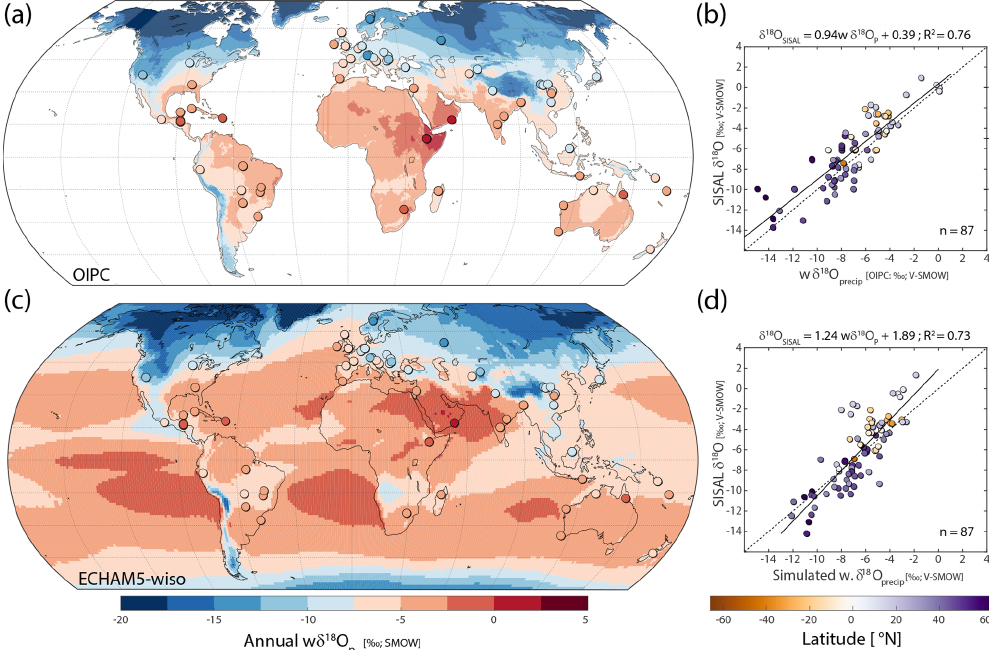
Figure 3. Comparison of SISAL data with observational and simulated wδ 18 O p for the modern period. (a) Comparison between SISAL δ 18 O averages (‰; V-SMOW) for the period 1960–2017 CE with OIPC data (‰; V-SMOW). (b) Scatterplot of SISAL modern δ 18 O averages as in (a) versus wδ 18 O p extracted from OIPC (i.e. background map in a ) at the location of each cave site. (c) Same as (a) with simulated wδ 18 O p data for the period 1958–2013 in the background. (d) Scatterplot of SISAL modern δ 18 O as in (c) versus the simulated wδ 18 O p for the period 1958–2013 CE. Dashed lines in (b) and (d) represent the 1 : 1 line. All SISAL isotope data have been converted to their drip-water equivalent, following the approach described in Sect. 3.2. Mean annual air surface temperature from CRU-TS4.01 (Harris et al., 2014) and mean annual simulated ECHAM5-wiso air surface temperature were used as surrogates for cave temperatures in the OIPC and ECHAM5-wiso comparison, respectively. See Sect. 2.3 for details on data extraction and conversion. Table 2. Number of SISALv1b speleothem records available for key time periods. Mid-Holocene (MH): 6 ± 0 . 5kyrBP; Last Glacial